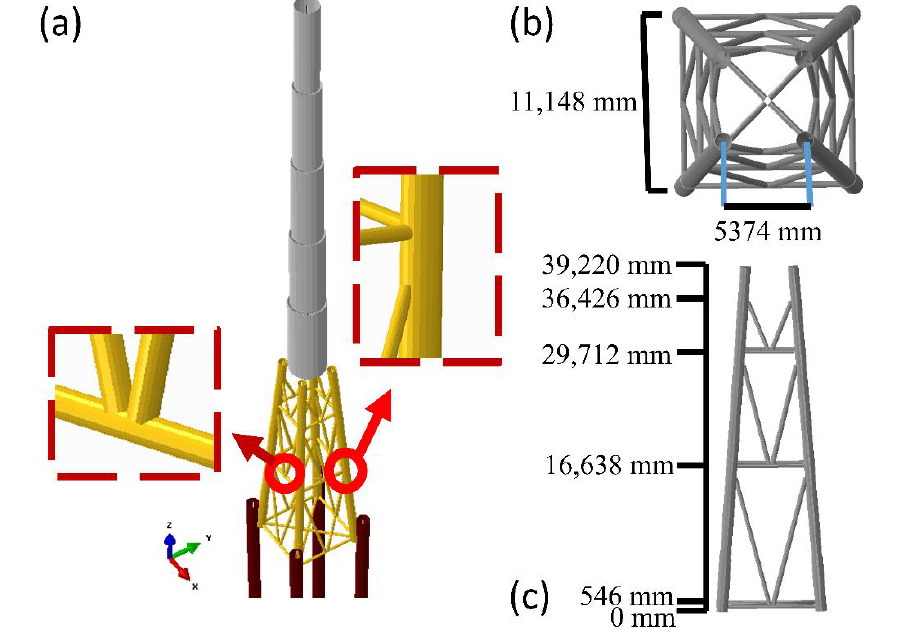
Figure 3. Offshore wind turbine (OWT) model with the K-type jacket substructure. ( a ) Wind tower, jacket substructure with the K joint (left) and KK joint (right), and four piles; ( b ) Top view of the substructure; ( c ) Front view of the substructure.